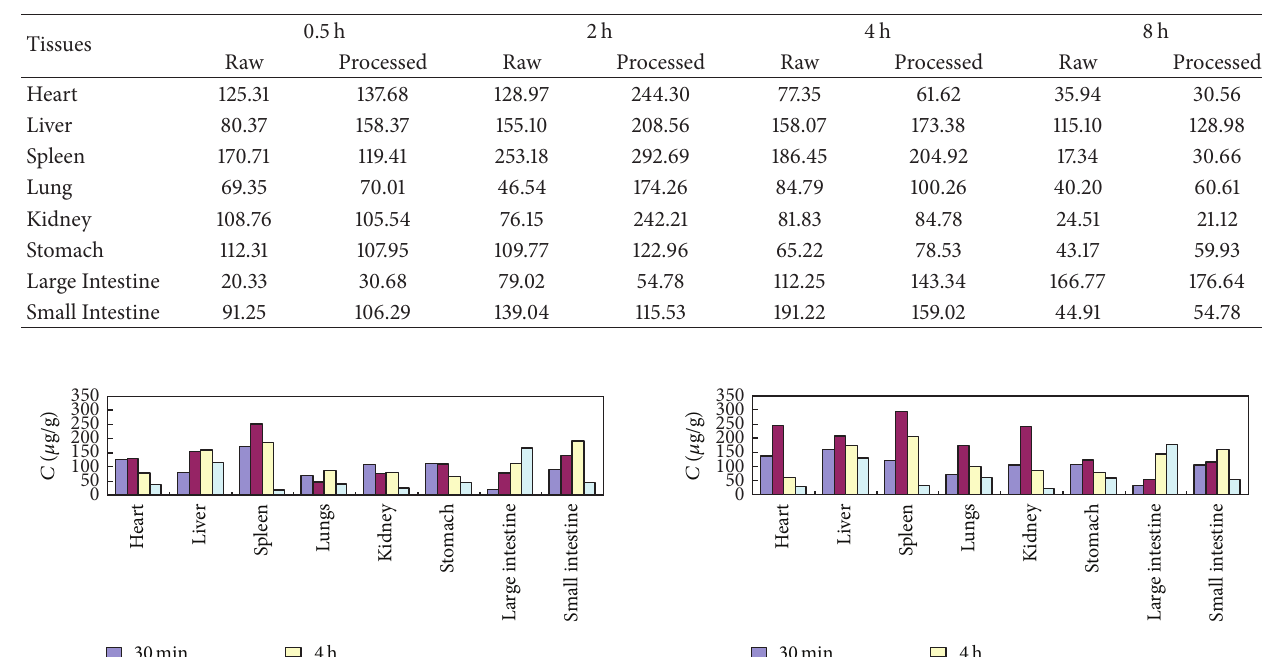
Table 3: The tissue concentrations of (4 E ,6 E ,12 E )-tetradecatriene-8,10-diyne-1,3-diyl diacetate after oral administration raw and processed AtractylodisRhizoma at a dose of 40 g ⋅ kg − 1 to rats, respectively ( 𝜇 g/g).